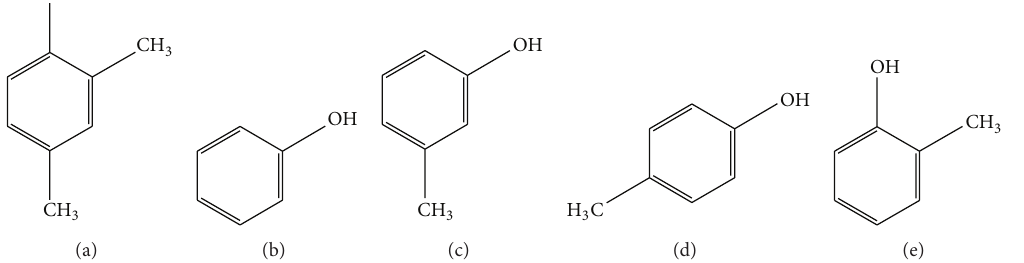
Figure 3: Chemical structure of the main phenolic compounds identified by GC-MS in the spent caustics mixture: (a) 2,4-dimethylphenol, (b) phenol, (c) m-methylphenol, (d) p-methylphenol, and (e)